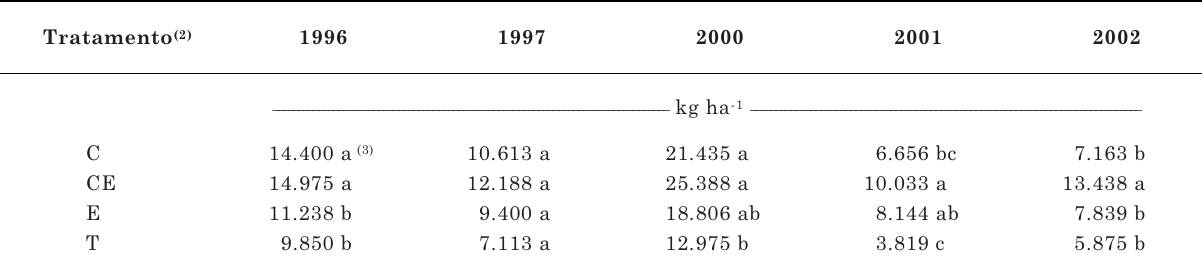
Quadro 2. Produtividade da batata em parcelas submetidas anualmente à adubação verde e, ou,